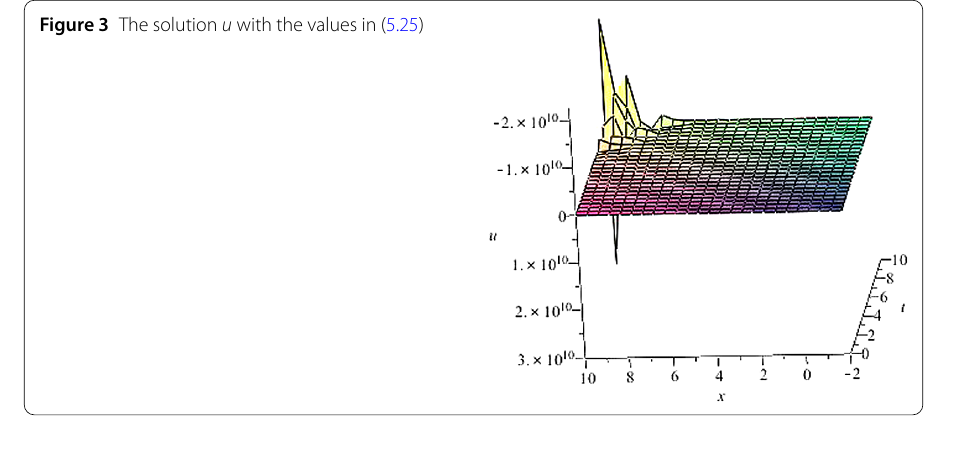
Figure 3 The solution u with the values in (5.25)